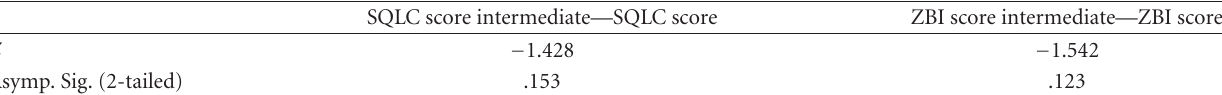
Table 6: Wilcoxon test for baseline and intermediate results of the Scale of Quality of Life of Caregivers and Zarit Burden Interview.